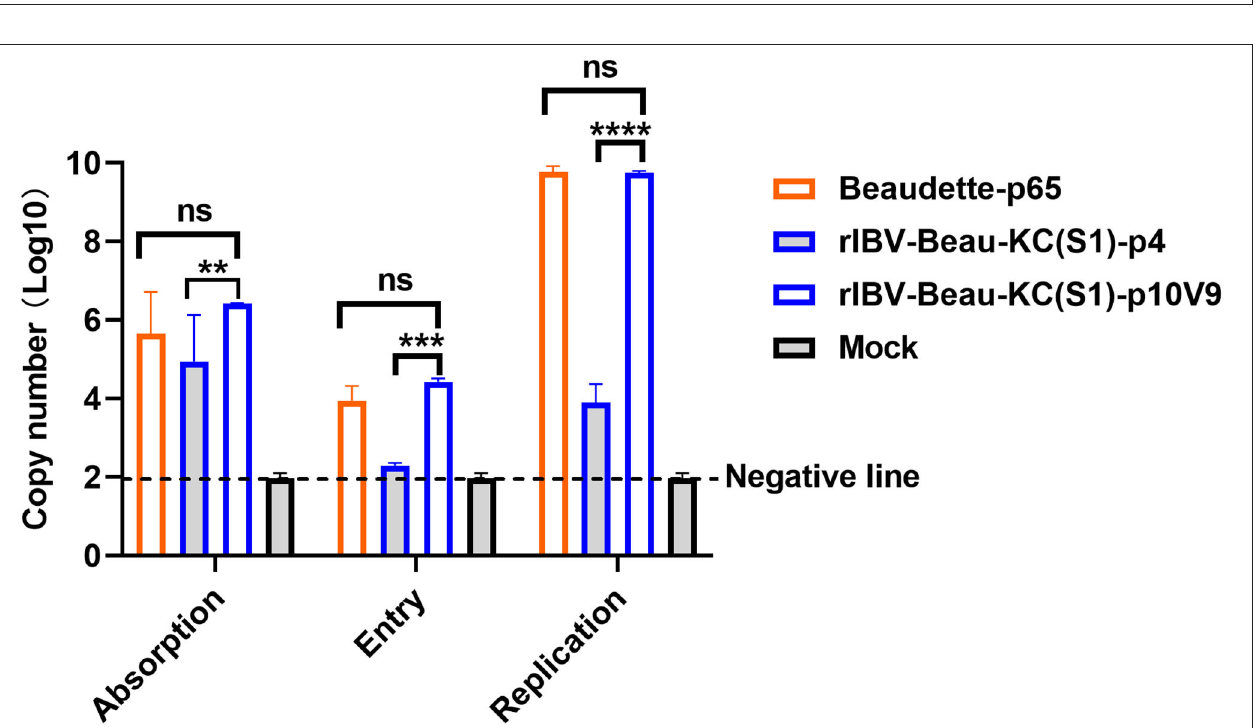
FIGURE 3 | stock were inoculated into 9-day-old SPF ECEs or Vero cells. For each dilution, 0.2mL of virus suspension was injected into each egg or added to cells in 96-well plates. Five eggs or plates were used for each dilution. The EID 50 and TCID 50 values were calculated by the method of Reed and Muench. Two-way analysis of variance (ANOVA) was used to analyze significant differences between the indicated samples and the respective control samples. Significance levels are presented by the P-value (ns, non-significant). (C) Growth kinetics of rIBV-Beau-KC(S1) in Vero, H1299, HeLa, and DF1 cells. Cells were infected with rIBV-Beau-KC(S1)-p10V9 and Beaudette-p65 at an indicated MOI, harvested at indicated time post-infection, and total RNAs were extracted. An equal volume of total RNA was reverse transcribed, and the levels of IBV genomic RNA were determined by RT-qPCR.